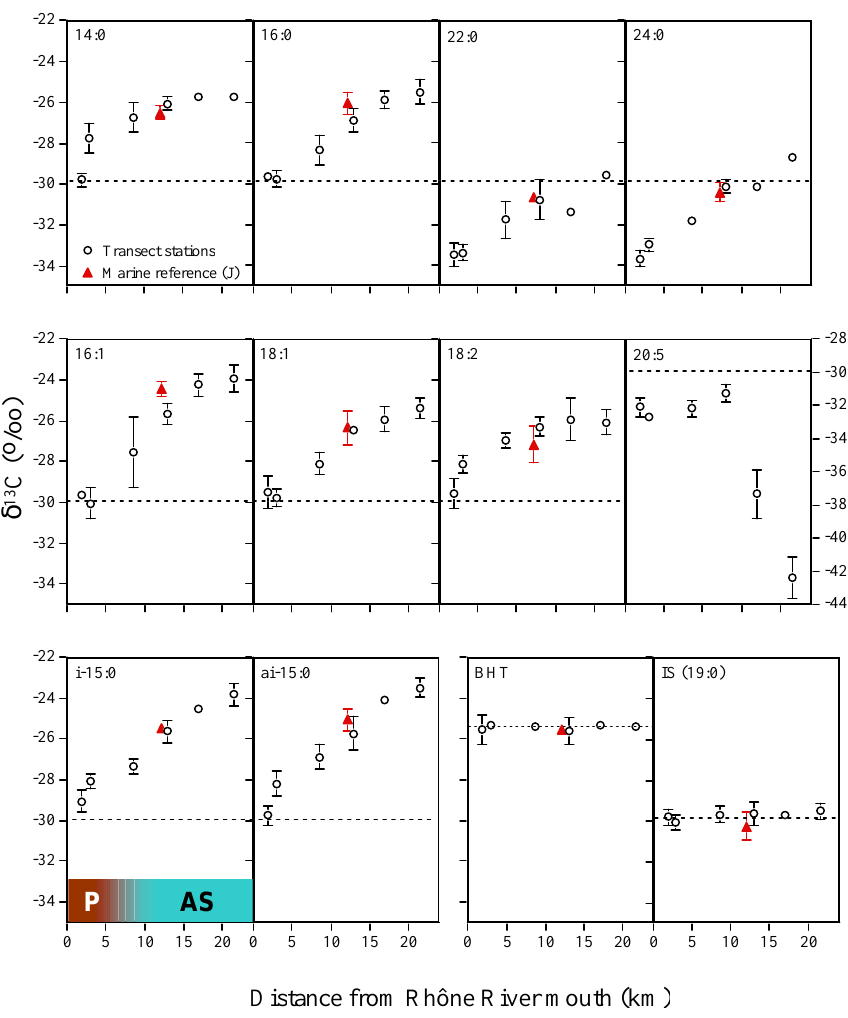
Fig. 5. Variations of δ 13 C of individual fatty acids in sediment samples collected along the prodelta-shelf transect (P and AS correspond to the prodelta and adjacent shelf, respectively). BHT stands for butylhydroxytoluene (antioxidant) and the Internal Standard (IS) used was nonadecanoic